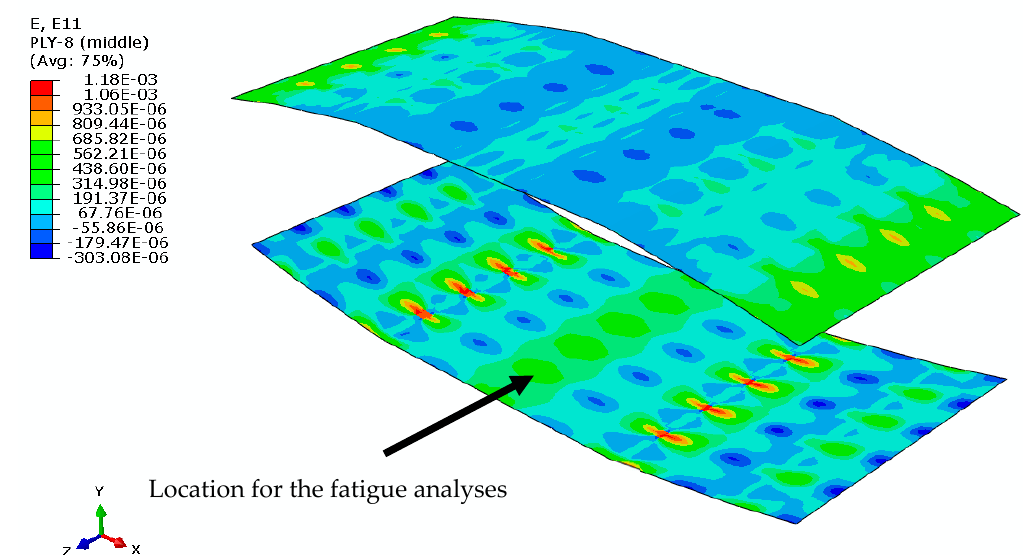
Figure 13. Strain distribution in the outer skin.